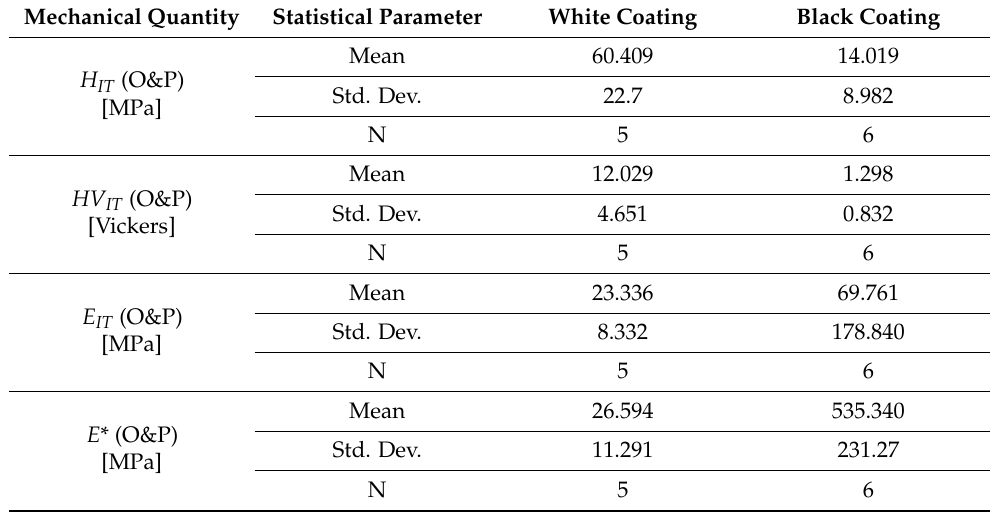
Table 1. Descriptive statistics of the indentation hardness and surface modulus of the tested materials. Mechanical